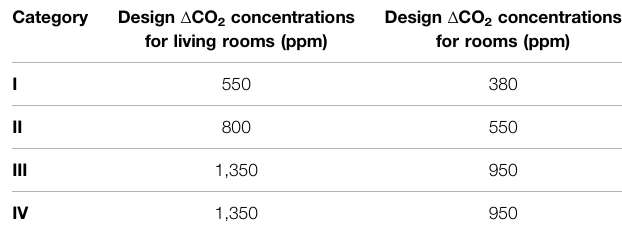
TABLE 4 | Design CO 2 concentrations for living rooms and occupied